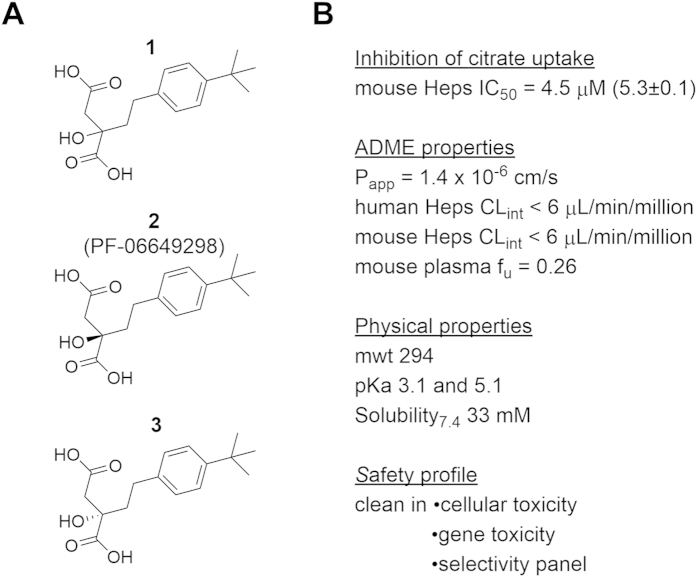
Structure of dicarboxylates 1–3 and in vitro profile of dicarboxylate 2 (PF-06649298).(A) Chemical structure of racemic dicarboxylate 1 and its enantiomers 2 and 3. (B) In vitro profile of dicarboxylate 2. Inhibition of citrate uptake was measured in mouse hepatocytes. IC50 is reported as a geometric mean of at least 3 replicates with pIC50 ± SD in parentheses. mwt = molecular weight. Papp = apparent passive permeability. Heps = hepatocytes. CLint = intrinsic clearance. fu = fraction unbound.